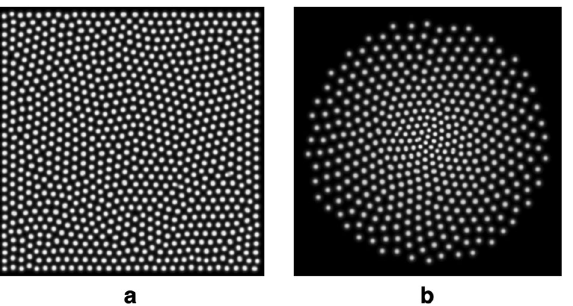
0.14 , D 0.06 , f 0.035 , v = = =